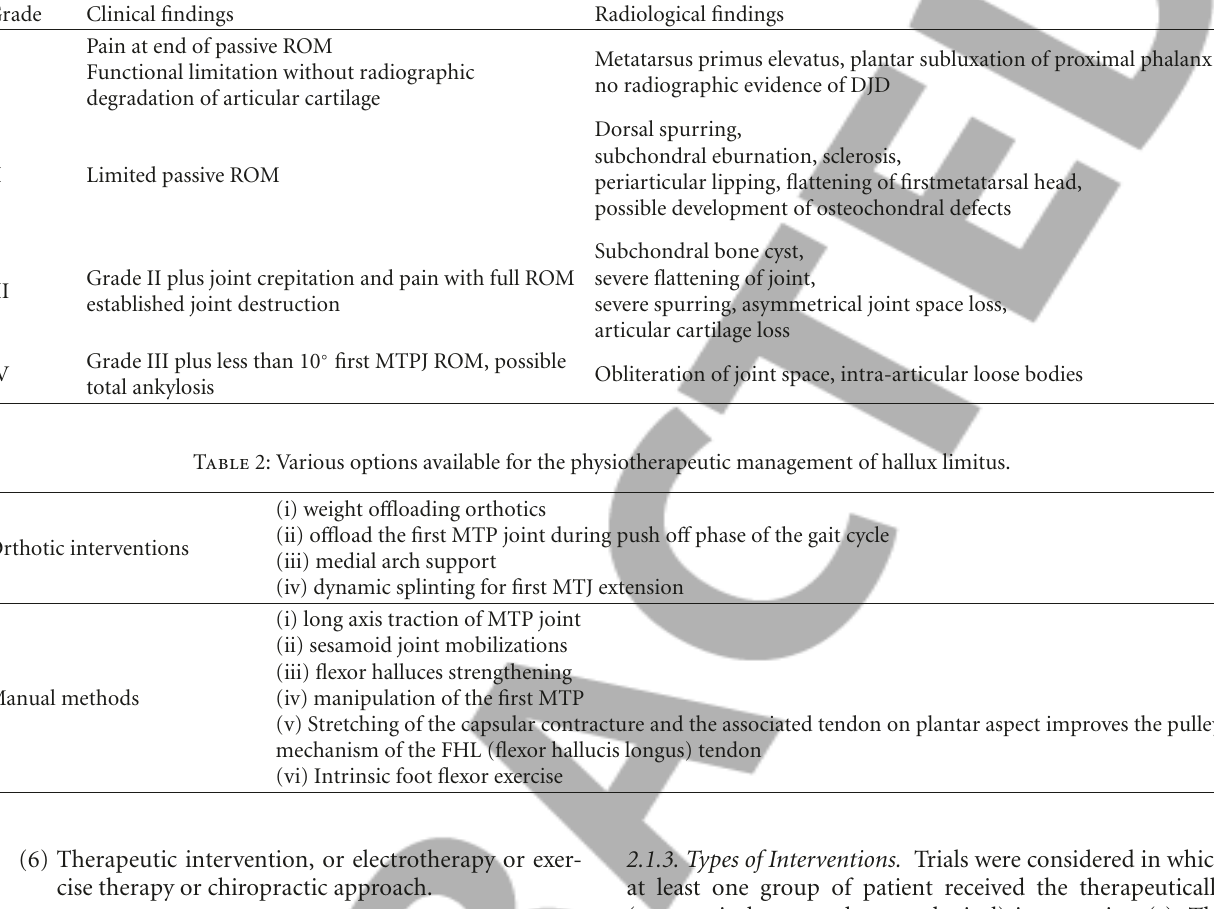
Table 1: Classification of the Hallux rigidus according to severity [14, 15].